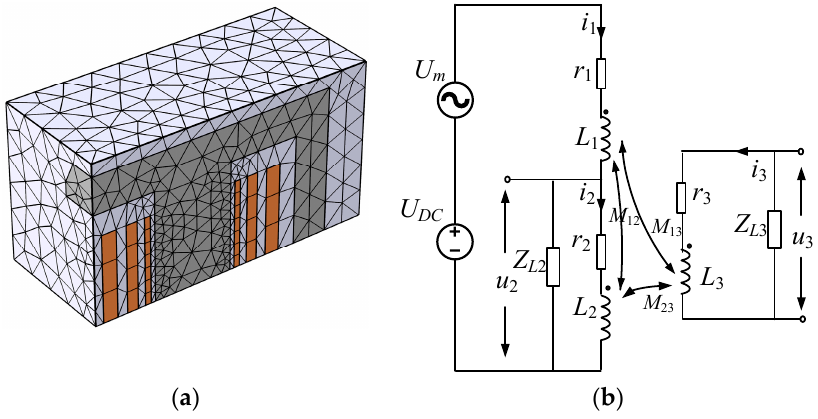
Figure 4. Field-circuit coupling model. ( a ) Eighth magnetic field model. ( b ) Circuit model.